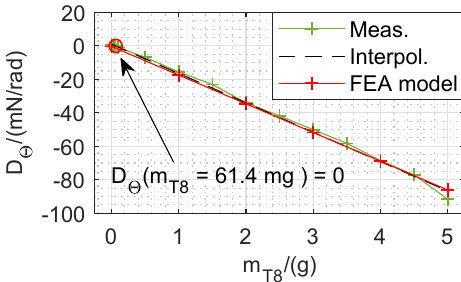
Figure 17. Influence of the trim weight ( m T 8 ) on the tilt sensitivity of the weighing cell.